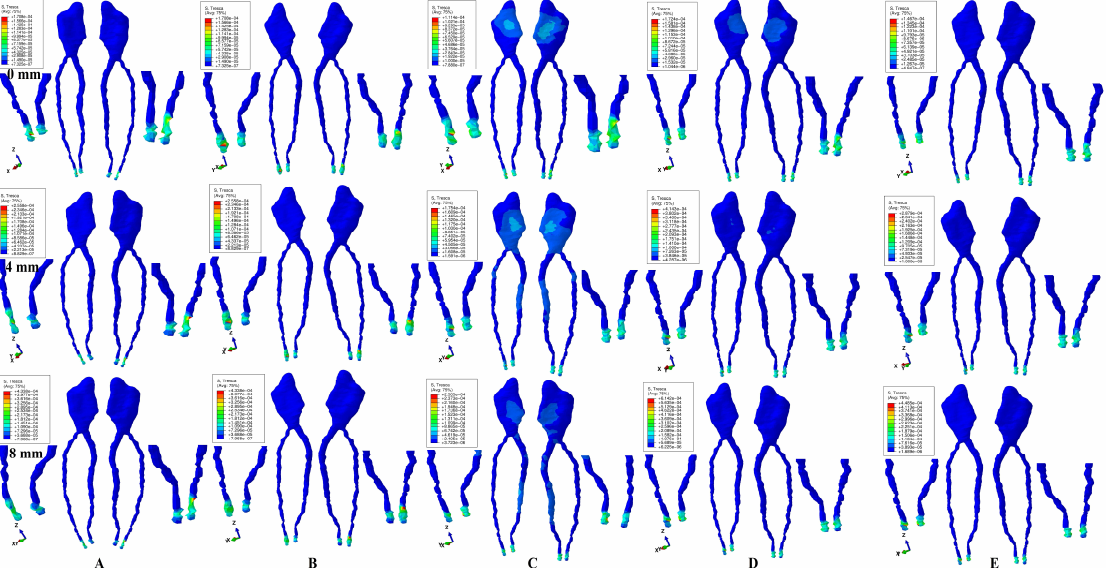
Figure 2. Tresca shear-stress display in dental pulp with its apical NVB (distal-vestibular and mesial-lingual, global, and detailed views) for 0.6 N (the quantitative values are in MPa) (intact, 4 mm and 8 mm reduced periodontium): ( A ) intrusion, ( B ) extrusion, ( C ) translation, ( D ) rotation, ( E ) tipping; the highest stressed areas are color-coded in red and orange.